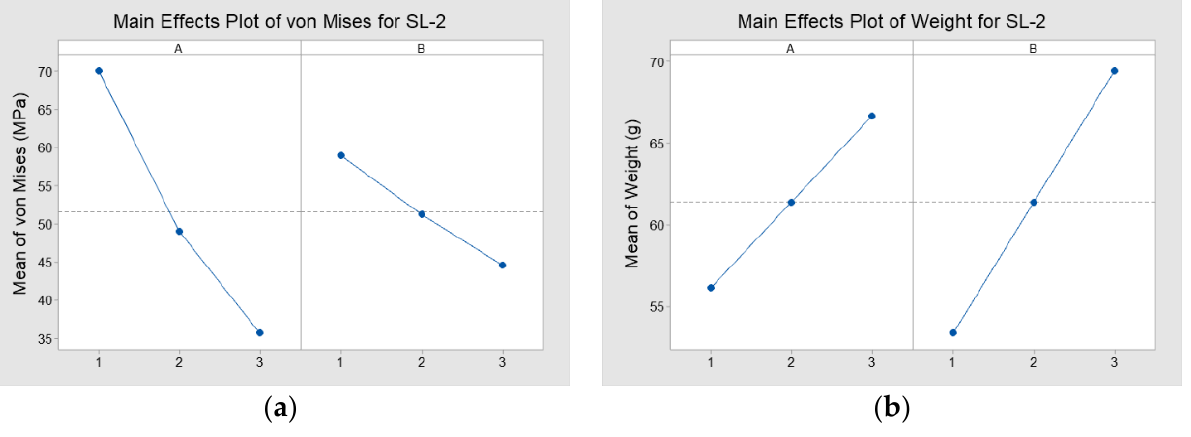
Figure 14. Study of the effect of the thickness of the first and second regions for the SH-2 structure.